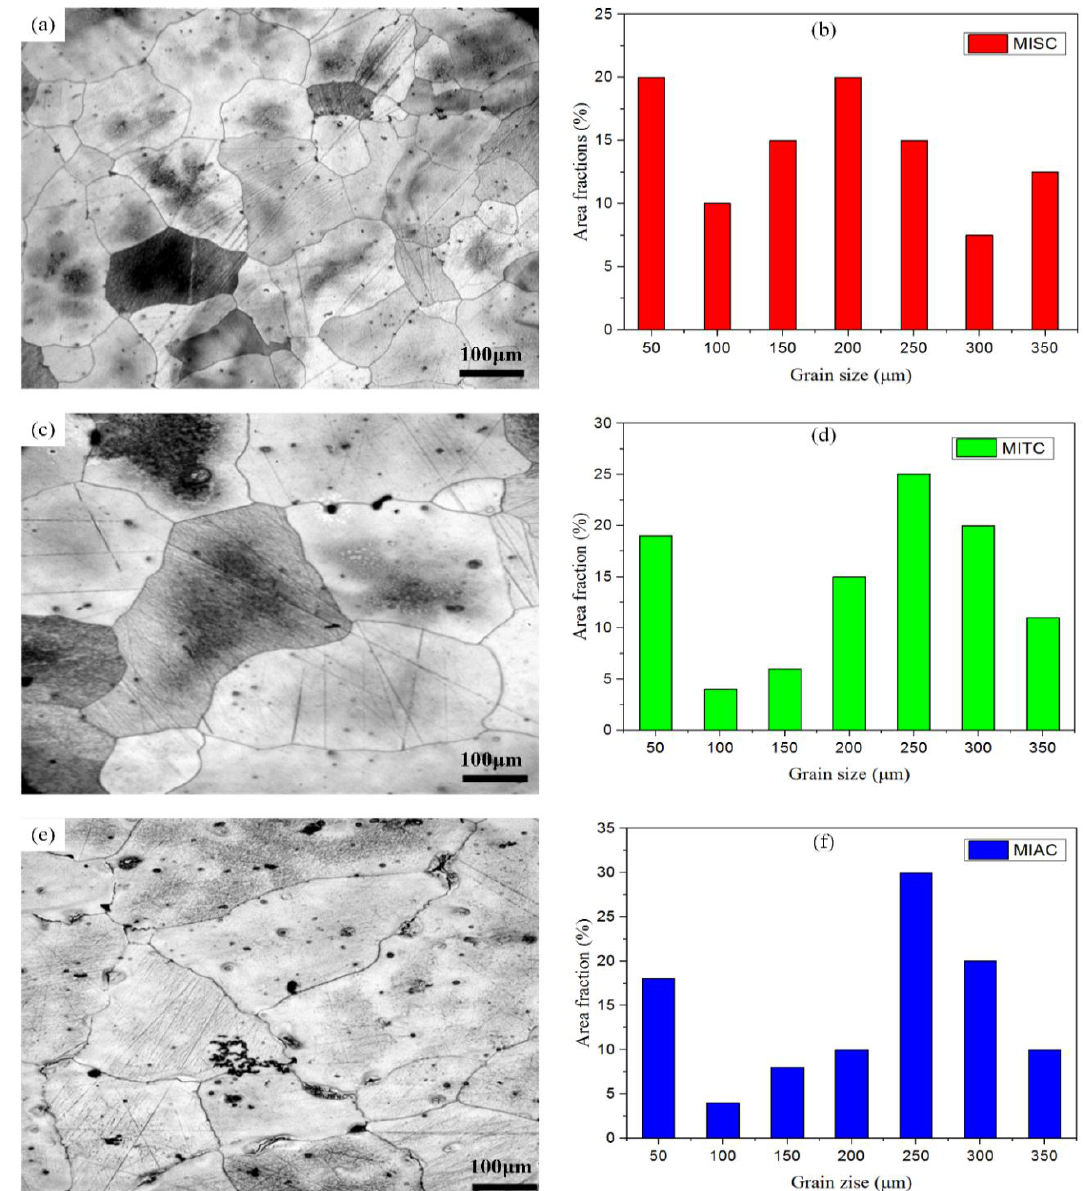
Figure 6. The optical microstructure and the grain size distributions of magnesium matrix composite in three kinds of reinforcement as-cast states: ( a , b ) MISC; ( c , d ) MITC; ( e , f ) MIAC.